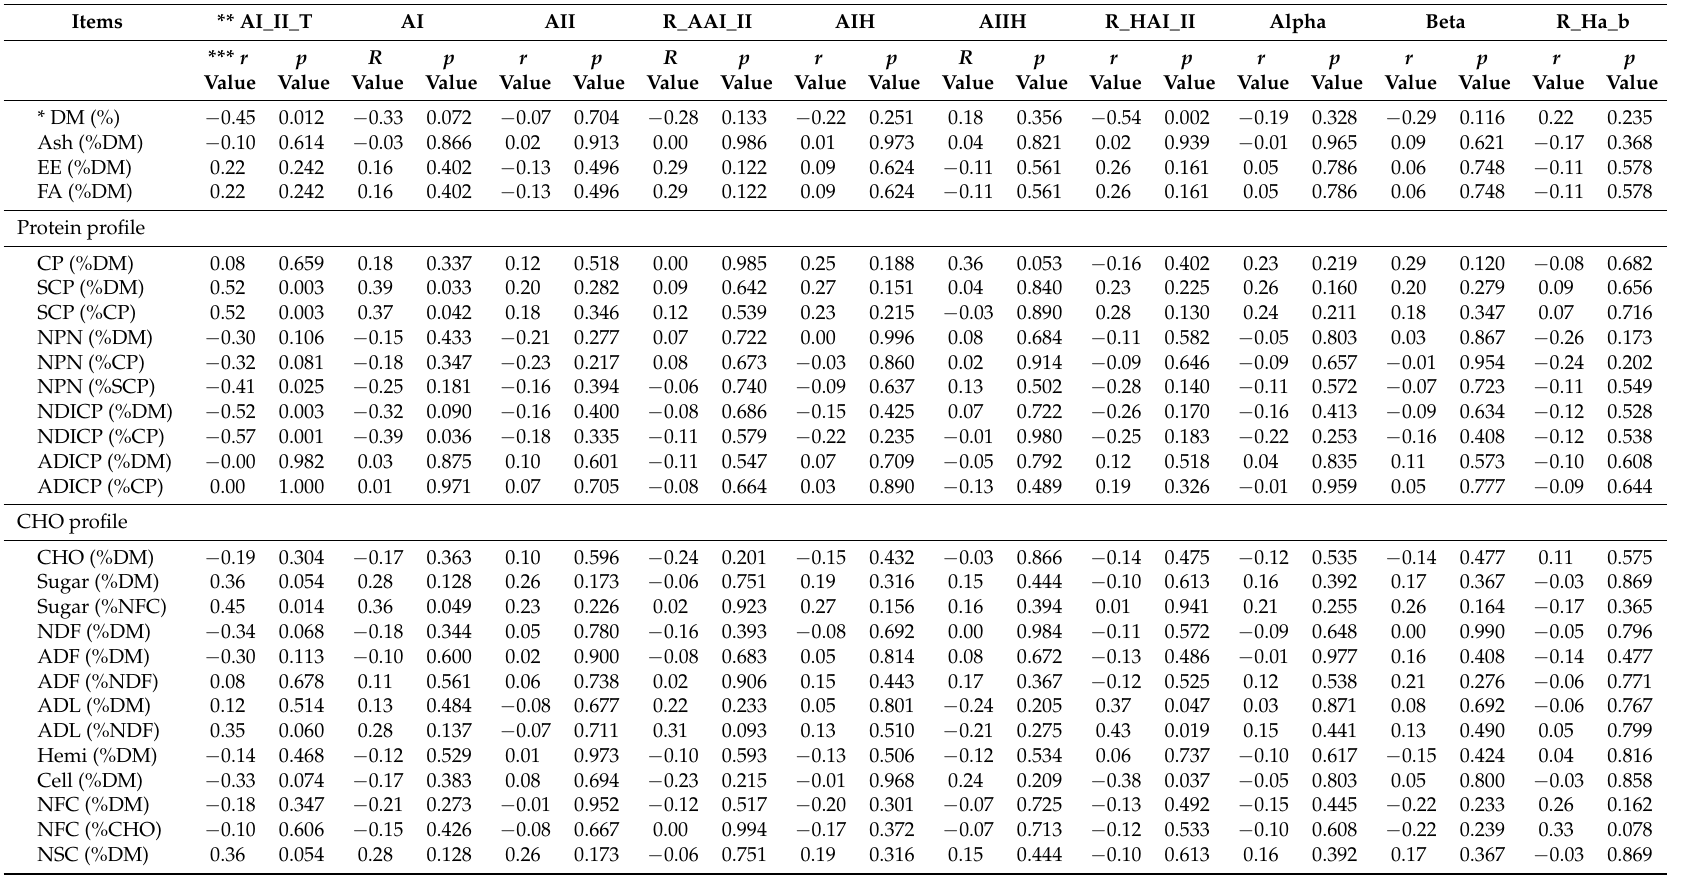
Table 7. Correlation analyses between protein structure spectral characteristics and chemical profile of canola